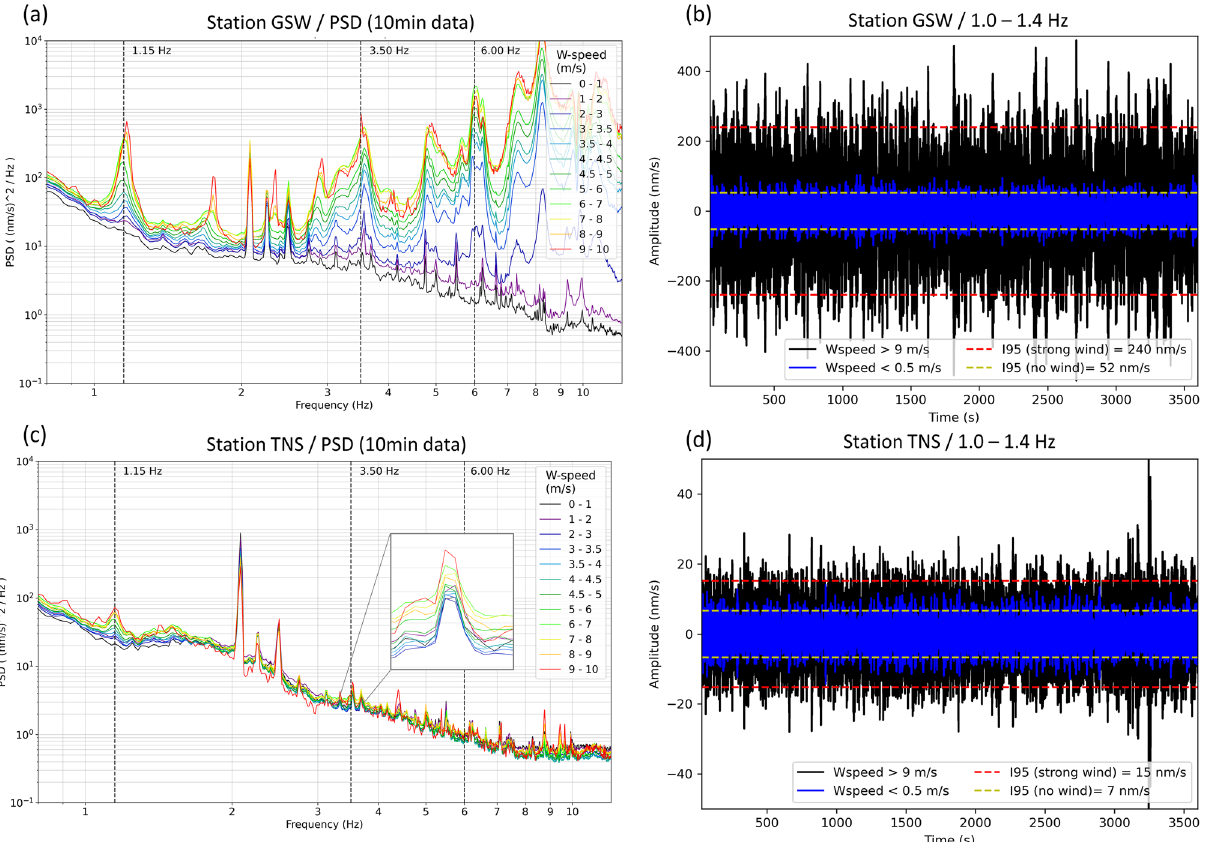
Figure 2. Power spectral density measured at near-field station GSW ( a ) and far-field station TNS ( c ) and correlated with the wind speed (from low wind speeds (black line) to high wind speeds (red line)) registered at the weather station Kleiner Feldberg. The amplitudes of the distinct peaks at 1.15 Hz and 3.5 Hz (inset in c ) increase with wind speed and are observable at both stations. At TNS, the amplitudes are lower than at GSW due to amplitude decay with distance. One-hour seismological records during wind speeds > 9 m s −1 (black waveform) and < 0.5 m s −1 (blue waveform) are measured at the station GSW ( b ) and TNS ( d ). The I95 value is calculated for the four records to derive noise amplitudes at TNS and at GSW during strong and low wind conditions. It should be noted that the scale of the y-axis in (b) is an order of magnitude greater than in ( d both stations are not increasing with the wind speed, which indicates that their origin is not related to the WTs. Moreover, additional discrete high-frequency (e.g., 6.0 Hz) peaks are observed at the near-field station (GSW), whose data are dominated by the WT-emitted signals (GSW is only 150 m from the closest WT), whereas this peak is not identified at TNS. These observations support the assumption that the two spectral peaks at 1.15 Hz and 3.5 Hz observed at TNS are associated with the operation of the Weilrod WF but are reduced in amplitude relative to those at GSW due to the decay of wave energy with increasing distance from the WF. Signals beyond 3.5 Hz that are detectable at GSW are not observable at TNS, due to attenuation and geometrical spreading effects and therefore are not considered further in the modelling. Next, to better quantify the spectral noise amplitudes of the WF signals with 1.15 Hz in terms of maximum ground velocities at GSW and TNS (Fig. 2b and d), we determine the I95 18 values (95.45% of the amplitudes are within two times the standard deviation) of the bandpass-filtered signals with cutoff frequencies of 1 Hz and 1.4 Hz. As in similar previous studies, we use noise levels in units of ground motion velocity to allow for a more direct comparison with signal amplitudes. However, corresponding values for acceleration and displacement at station GSW and TNS are listed in the supplements (Tab. S1). For each station, we select a 1-h time segment with a wind speed < 0.5 m s −1 and another one-hour time segment with a wind speed > 9 m s −1 . The I95 noise amplitudes at GSW (TNS) in the near (far) field are approximately 240 nm s −1 (15 nm s −1 ) at a high wind speed and 52 nm s −1 (7 nm s −1 ) at a low wind speed. We conclude that at high wind speeds and within the frequency range of 1–1.4 Hz, the Weilrod WF, on average, causes a 2.1-fold increase (from 7 to 15 nm s −1 ) in the noise level at TNS and that the seismic signals produced by the Weilrod WF are detectable in 11 km at TNS, because of the overall low noise level at TNS. Such an increase can affect the ability to detect small earthquakes and it can also have an impact on the determination of earthquake magnitude.